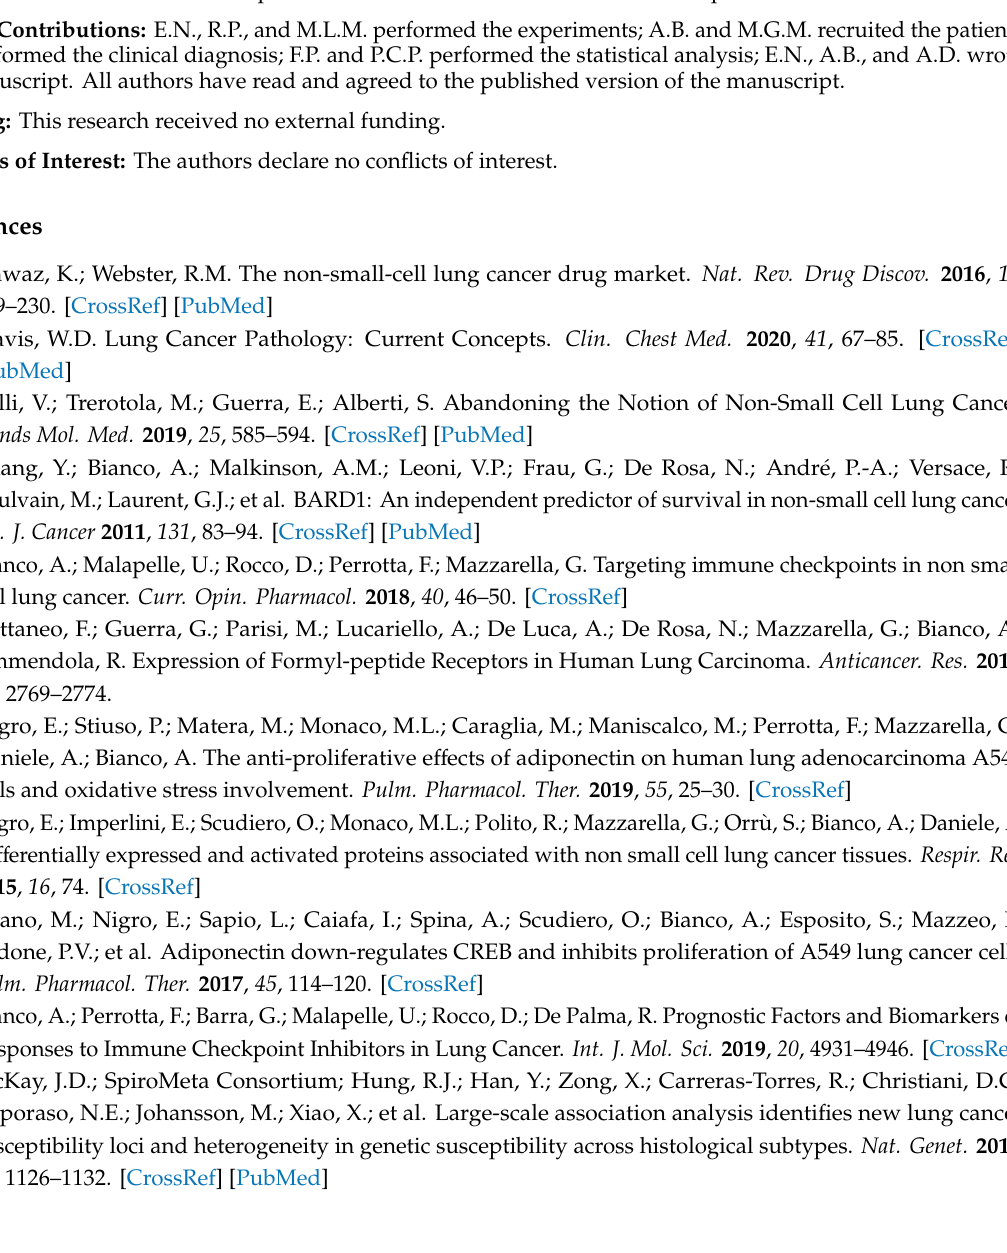
Table S1: Correlation between Adiponectin levels and clinical and laboratoristic